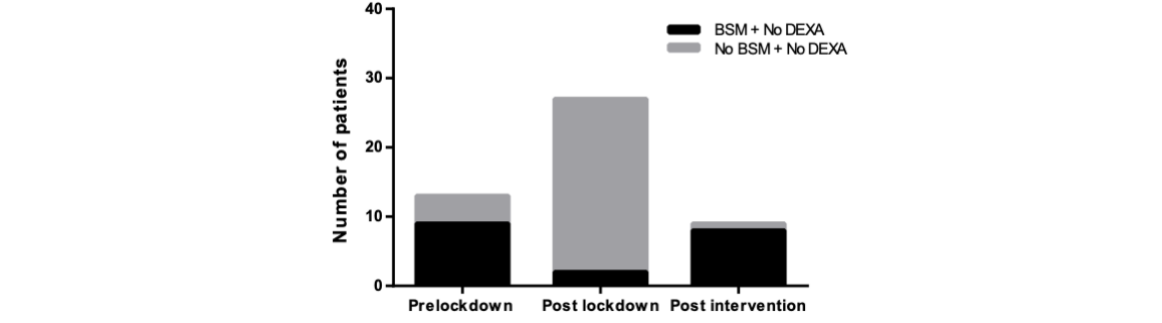
Figure 6. The number of DEXA (dual energy X-ray absorptiometry)-eligible patients who did not have a DEXA scan requested but were started on bone-sparing medication (BSM) significantly dropped following the lockdown ( P <.001). Post intervention, this significantly increased ( P <.001), with greater numbers of patients prescribed